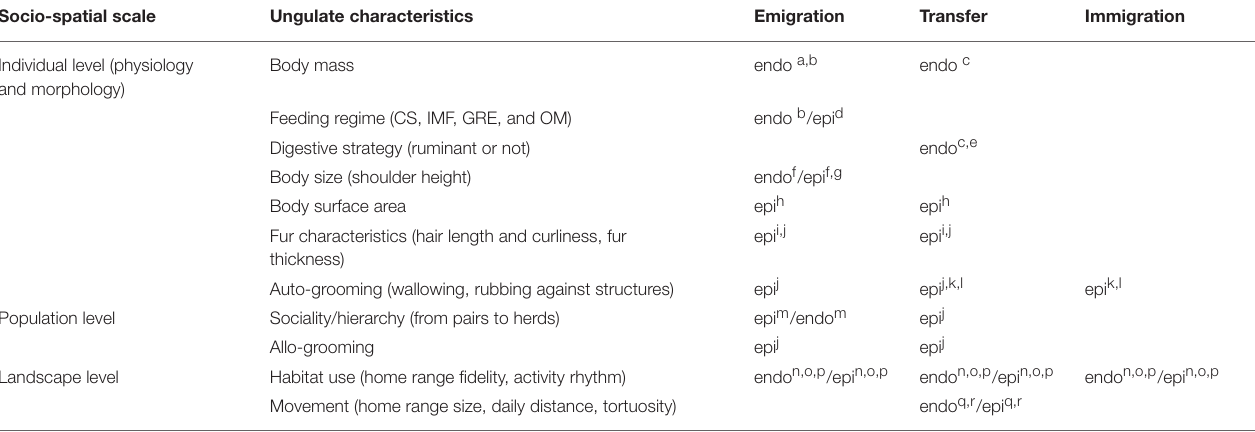
TABLE 2 | Effects of ungulate functional diversity gradients on the different phases of internal (endo: endozoochory and regurgitation) and external (epi: fur-epizoochory) plant dispersal (CS: Concentrate Selector, IMF: Intermediate Mixed Feeder, GRE: Grass and Roughage Eater and OM: Omnivore). Socio-spatial scale Ungulate characteristics Individual level (physiology and